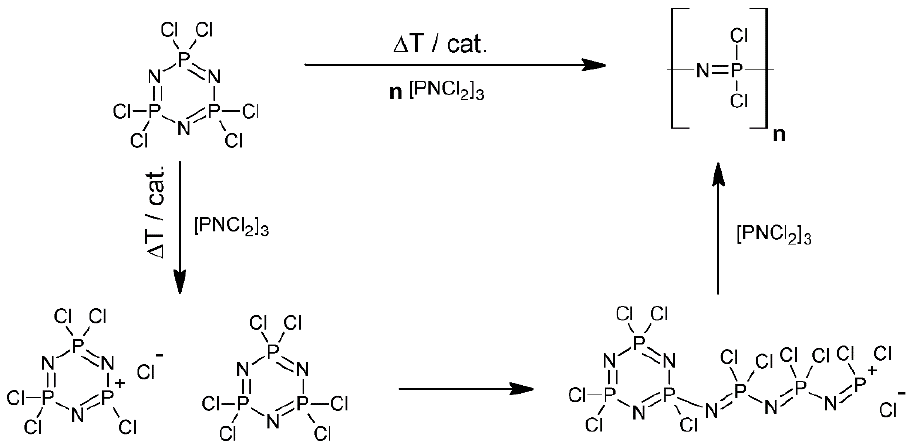
Figure 2. Some supramolecular arrangements of phosphazenes: tapes and polymersomes.